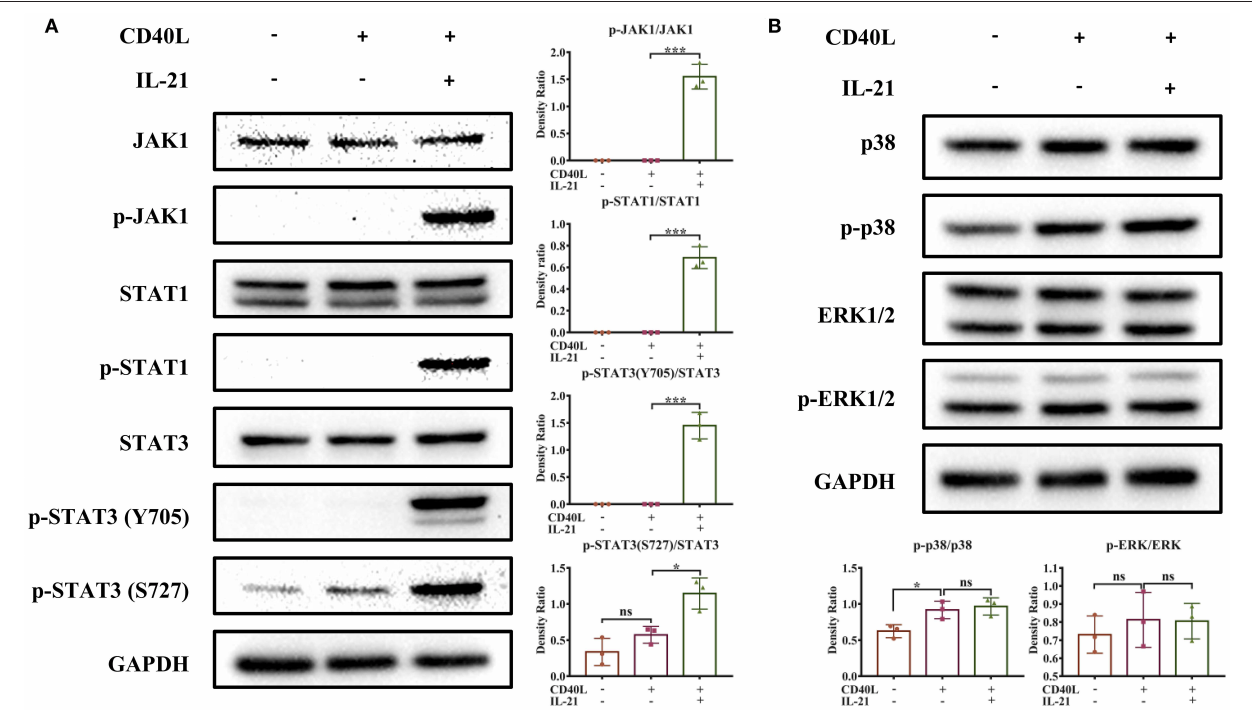
FIGURE 5 | IL-21 activates JAK1, STAT1, and STAT3 in IgM + B cells. IgM + B cells from Peyer’s patches were cultured with or without CD40L overnight and then stimulated with or without IL-21 for 2h. Western blotting was performed to detect total or phosphorylated proteins involved in JAK-STAT, MAPK, and PI3K-AKT signaling pathways. Representative plots of three independent experiments for the detection of total or phosphorylated JAK1, STAT1, and STAT3 proteins (A) , as well as p38 and ERK1/2 proteins (B) , are shown. The cumulative density ratio of phosphorylated protein normalized by total protein is also shown. * p ≤ 0.05; *** p ≤